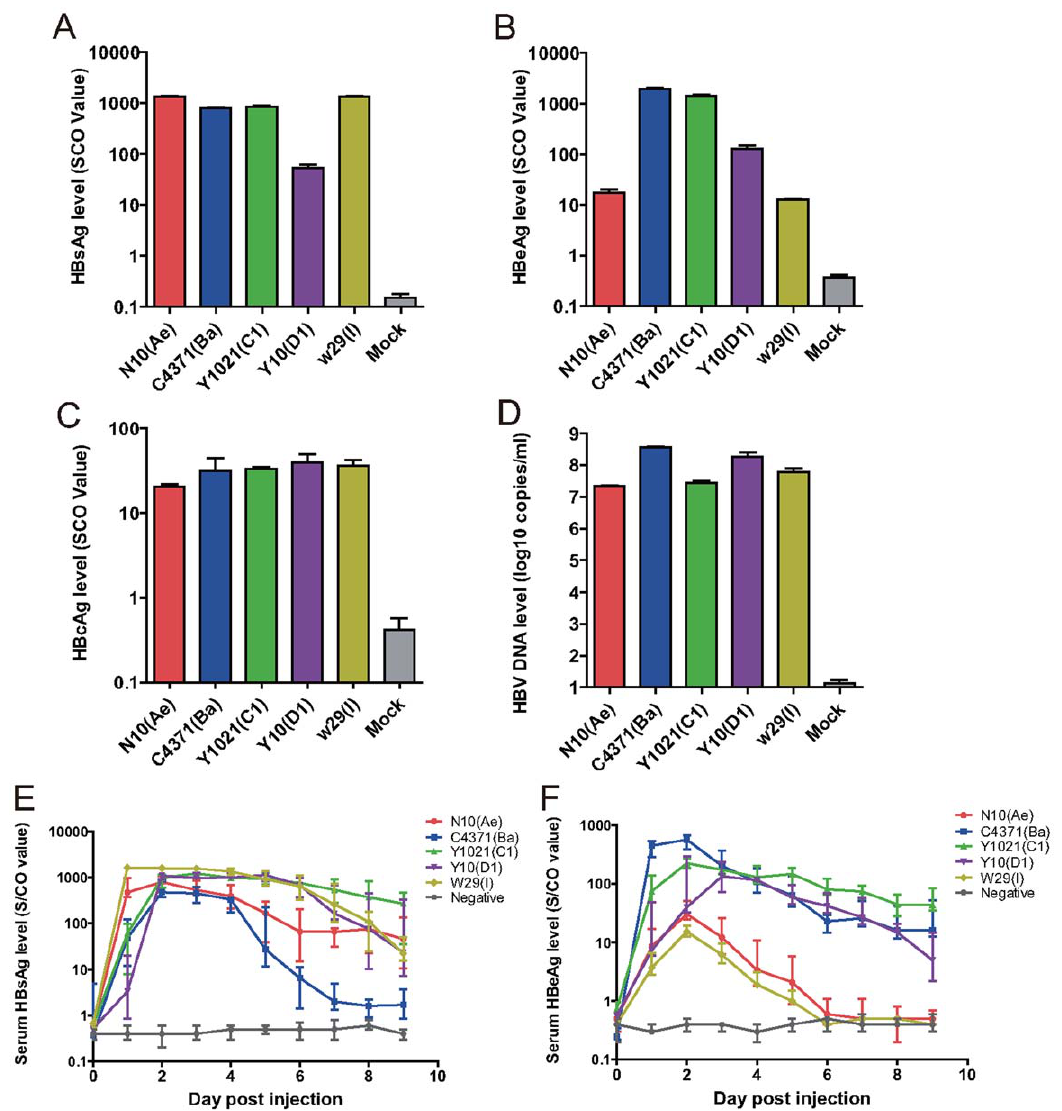
Figure 6. Comparison of expression levels of HBV markers between different genotypes invitro and invivo . Fig. a, b, c, d: HBsAg, HBeAg, HBV DNA and HBcAg levels in Huh7 cell culture supernatant. SEAP reporter plasmid was co-transfected with each HBV plasmid as an internal control. The SEAP activity of the first group (transfected with N10 (Ae) plasmid) was set as 1.0 and served as a reference, and the other groups were calculated as relative SEAP activity. The presented data are a ratio of actual value to the relative SEAP activity value. Fig. e, f: Dynamic curve of HBsAg and HBeAg expression levels in serums of hydrodynamic-injected mice. For each HBV plasmid, five mice were repeated. Due to the limited serum resources, each sample was diluted 10-fold for